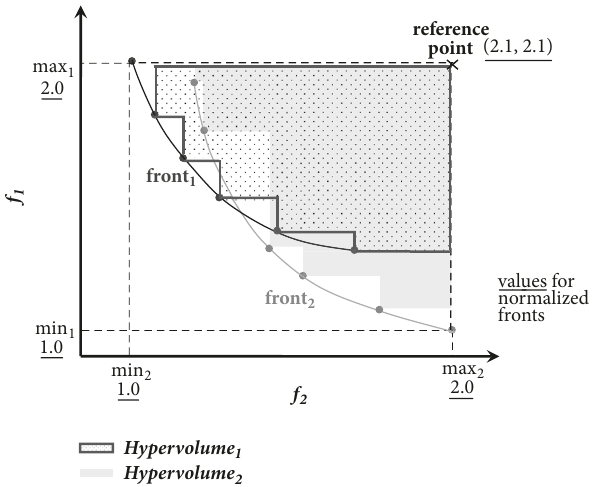
Figure1:Hypervolume(hereanarea,for2objectivefunctions)for2 fronts(inspiredfrom[36]).Objectivefunctionsaretobeminimized.